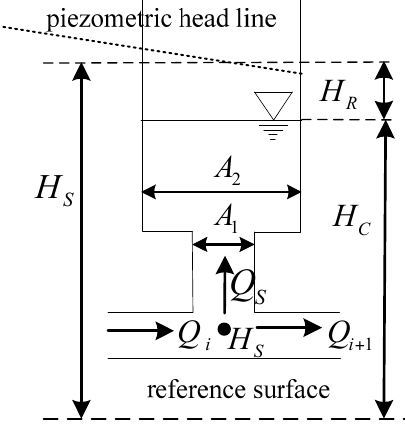
Figure 3. Schematic diagram of the impedance surge tank.